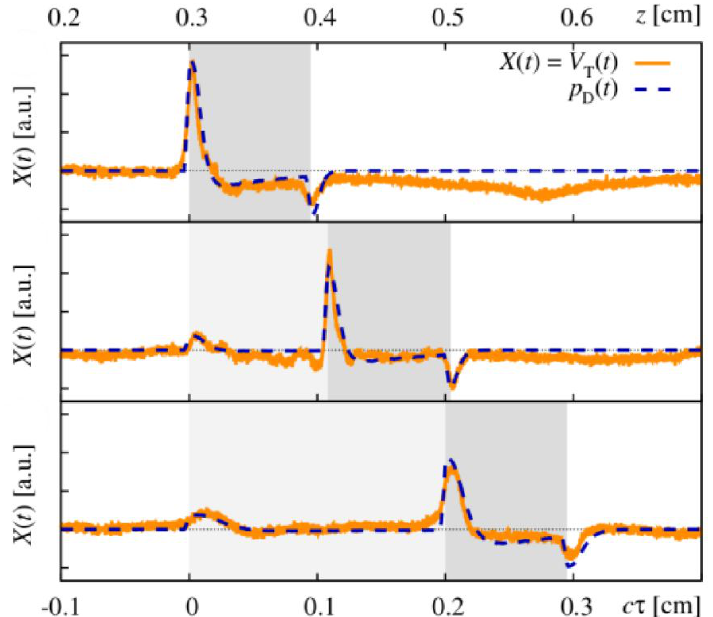
Figure 22. Experimental (yellow curve) and numerically calculated (dashed line) optoacoustic signals of poly(vinyl alcohol) (PVA) hydrogel layers with different absorption properties (different shades of gray) realized by melanin staining and measured with a detector in the far field. Melanin concentration in the different layers was chosen to match physiologic conditions (reproduced with permission from